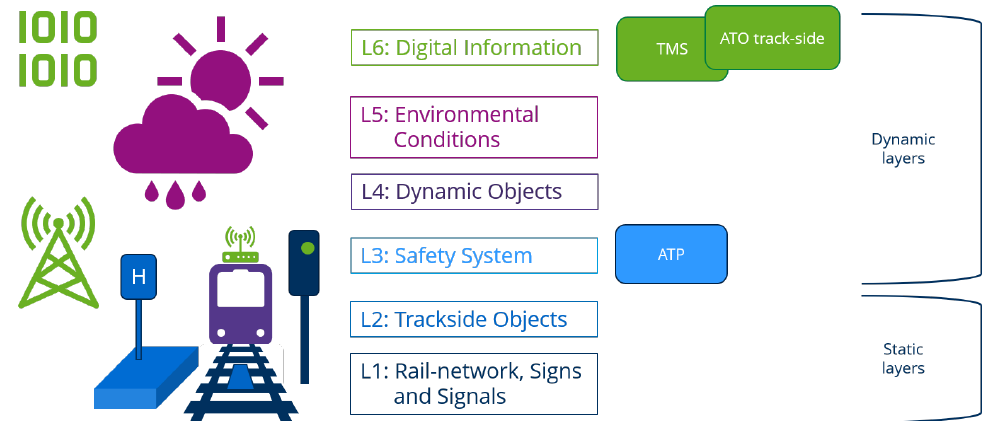
Figure 2. Layer model for the railway sector derived from the 6LM in